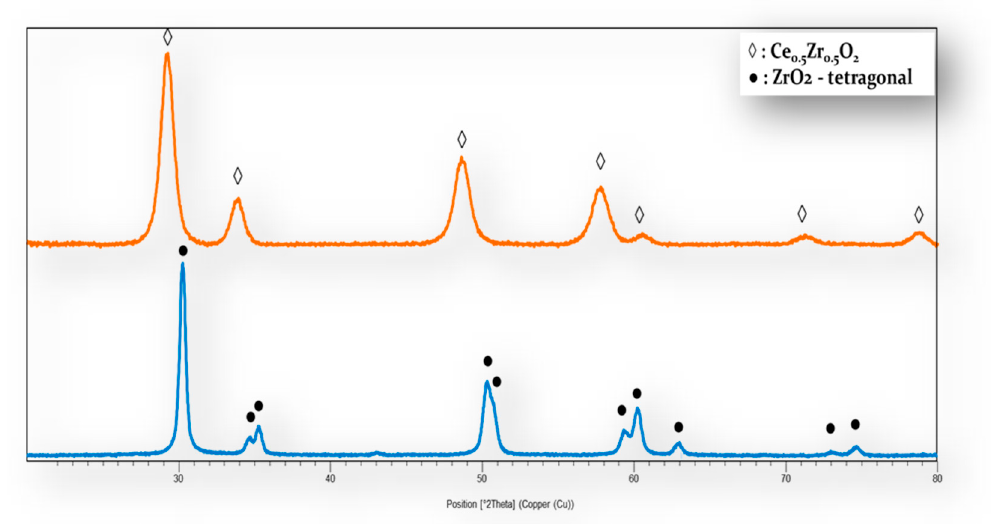
Figure 1. X-Ray Di ff raction (XRD) spectra of the Ce 0.5 Zr 0.5 O 2 (CZOm) and ZrO 2 (ZOm) samples synthetized by microemulsion and followed by calcination at 750 ◦ C. Table 1. Surface area, pore volume, and average pore diameter of the CZOm and ZOm. Surface Area (m 2 /